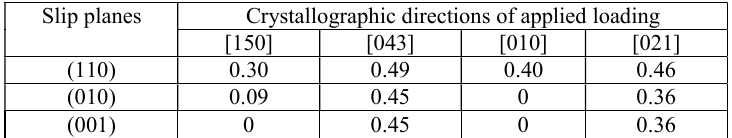
Table 1. Schmid factor for some of the directions and slip planes